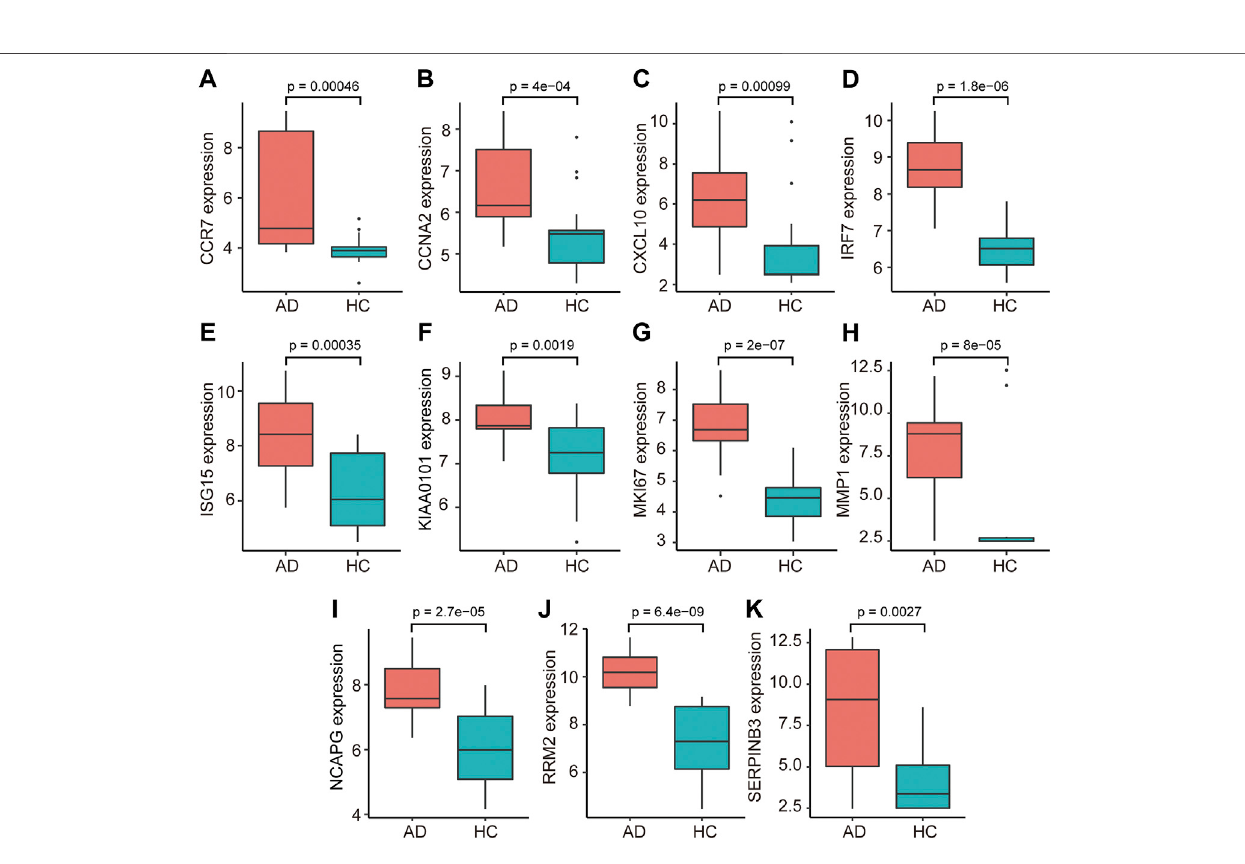
Frontiers in Molecular Biosciences |